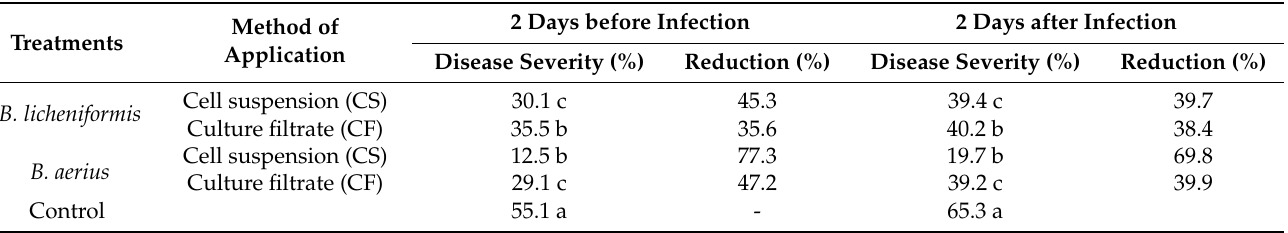
Table 4. Effect of Bacillus licheniformis and B. aerius on disease severity under artificial infection in pots.